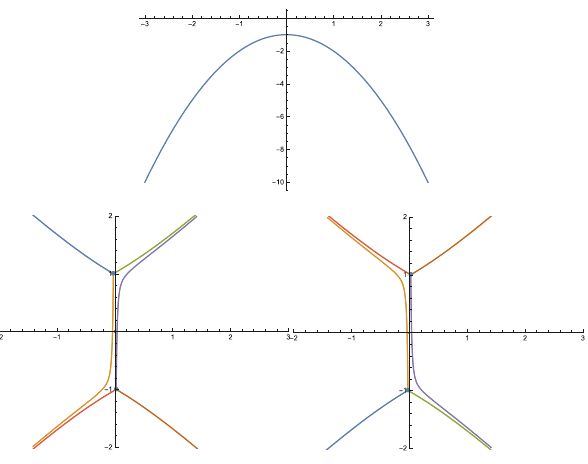
Figure 3 . In the upper panel, the potential ( V ( x ) = − 1 − x 2 ) is shown on the V − x plane. In the lower panel, the Stokes lines of Q ( x ) = − 1 − x 2 ± 0 . 05 i are shown on the complex x - planes. One can see that there is a discontinuity between Q ( x ) = − 1 − x 2 + 0 . 05 i (lower left) and Q ( x ) = − 1 − x 2 − 0 . 05 i (lower